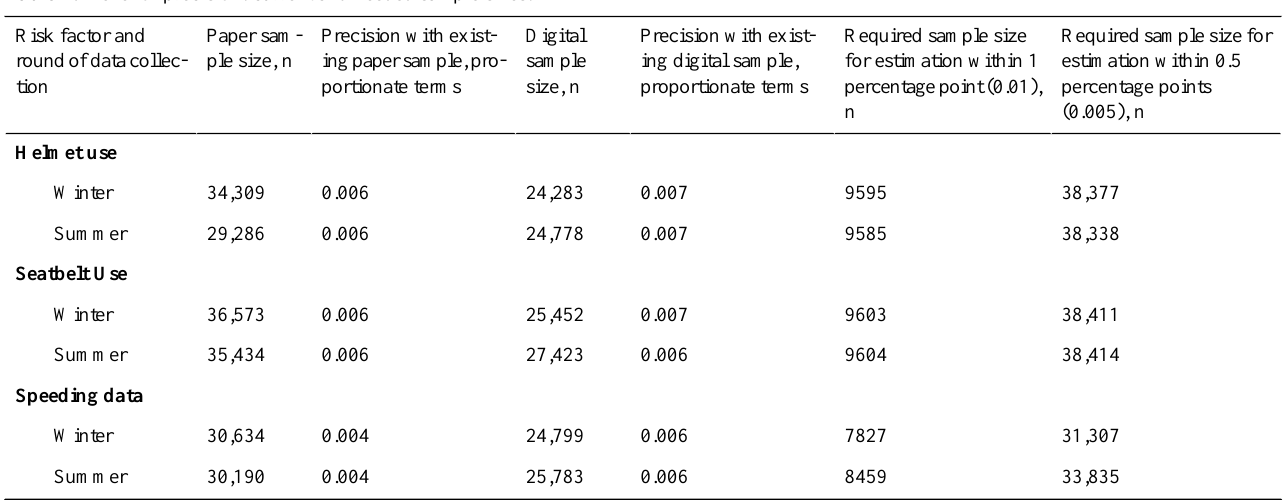
Table 2. Level of precision: current and needed sample